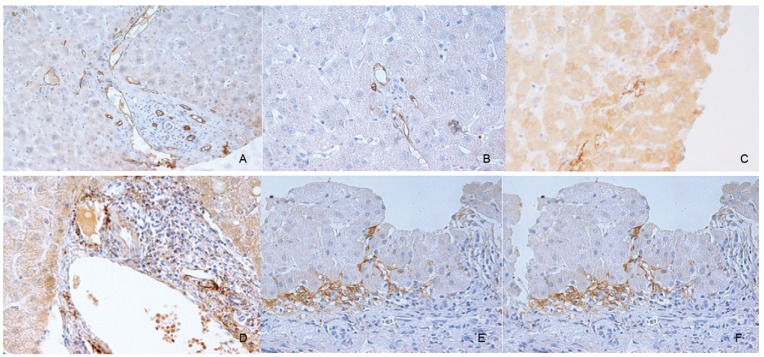
C4d immunostaining. A: acute rejection in patients undergoing liver
transplant for hepatitis C (RejHCV+) group case with mild acute rejection
(Banff 1/1/1) and strong C4d immunoreactivity in the endothelial cells of
portal veins (400X); B: RejHCV+ group case with moderate acute rejection (Banff
2/2/2) and moderate C4d immunoreactivity in the endothelial cells of hepatic
(centrilobular) vein (400X); C: acute rejection in patients undergoing liver
transplant for reasons other than hepatitis C (RejHCV-) group case with severe
acute rejection (Banff 3/3/3). Despite moderate background staining in
hepatocytes, C4d immunoreactivity in the endothelial cells of hepatic
(centrilobular) vein is quite evident (200X); D: chronic hepatitis C in
patients in a non-transplant setting (HCVTx-) group case staged as representing
Ishak grade 1 fibrosis and grade 2 periportal inflammation with C4d
immunoreactivity in the endothelial cells of portal vein branches (400X); E:
RejHCV- group case with severe acute rejection (Banff 2/2/3) presenting C4d
immunoreactivity in endothelial cell membranes of pericentral sinusoids (400X);
F: HCVTx- group case staged as representing Ishak grade 5 fibrosis and grade 0
periportal inflammation with C4d immunoreactivity in endothelial cell membranes
of periseptal sinusoids (400X).